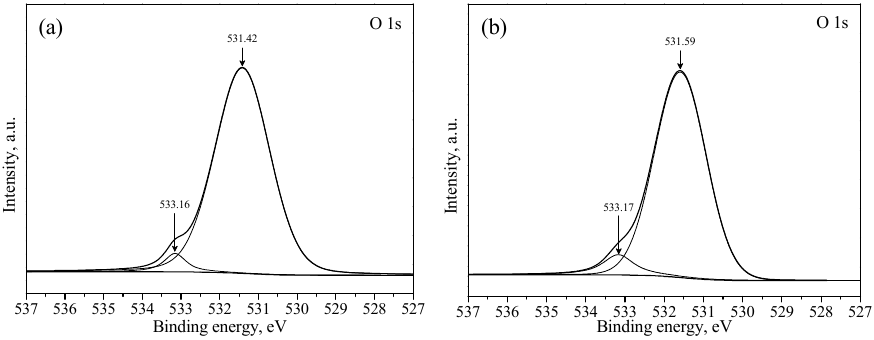
Figure 4. O 1s spectra for the mineral surface treated with chloride ions: ( a ) before; ( b ) after.